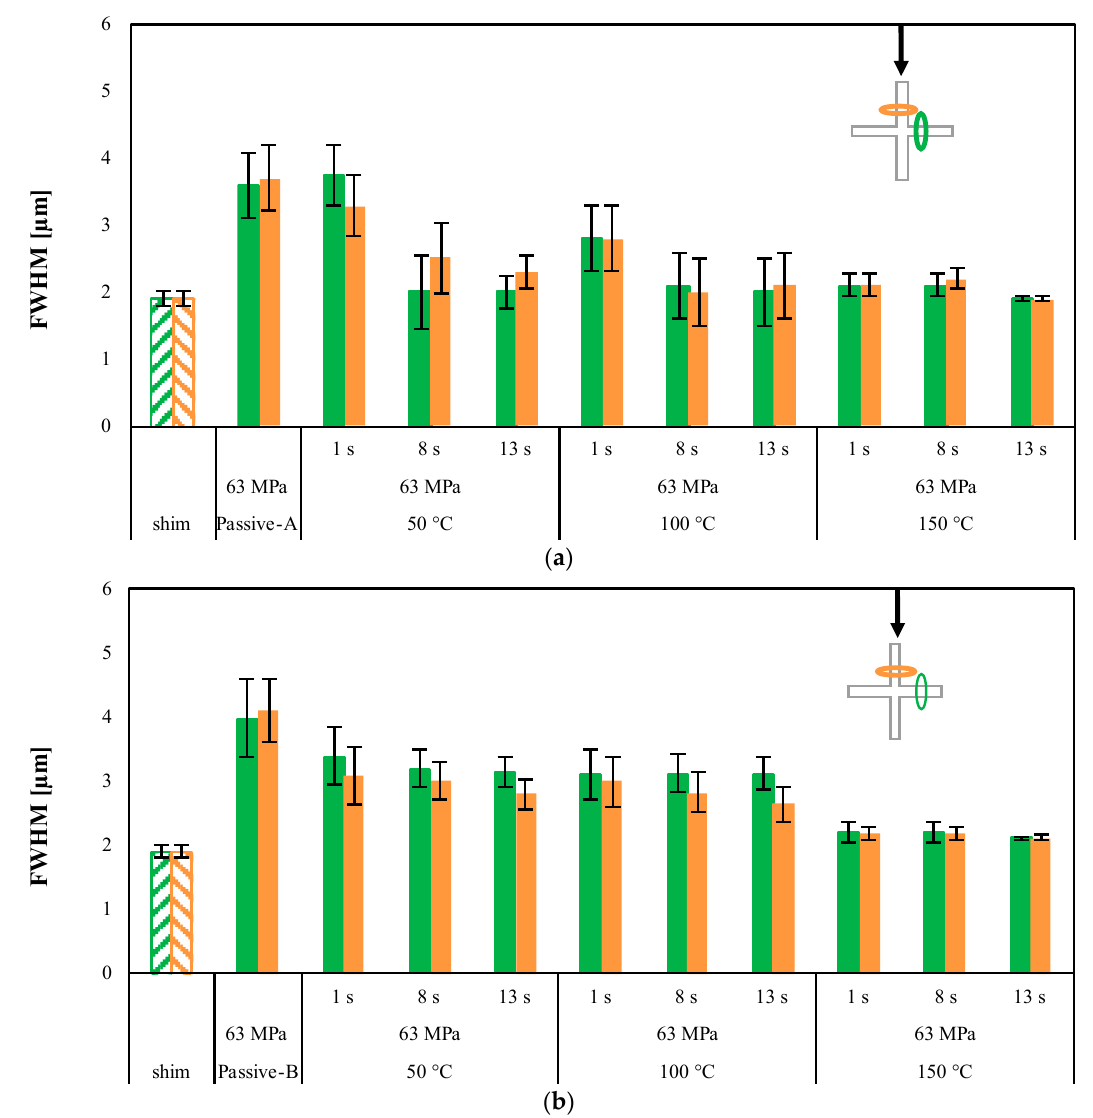
Figure 4. FWHM index of micro-feature on PLA3251D ( a ) and PLA4032D ( b ) samples obtained as indicated in Table 1. A sketch of the area where the AFM patterns have been acquired is also reported.